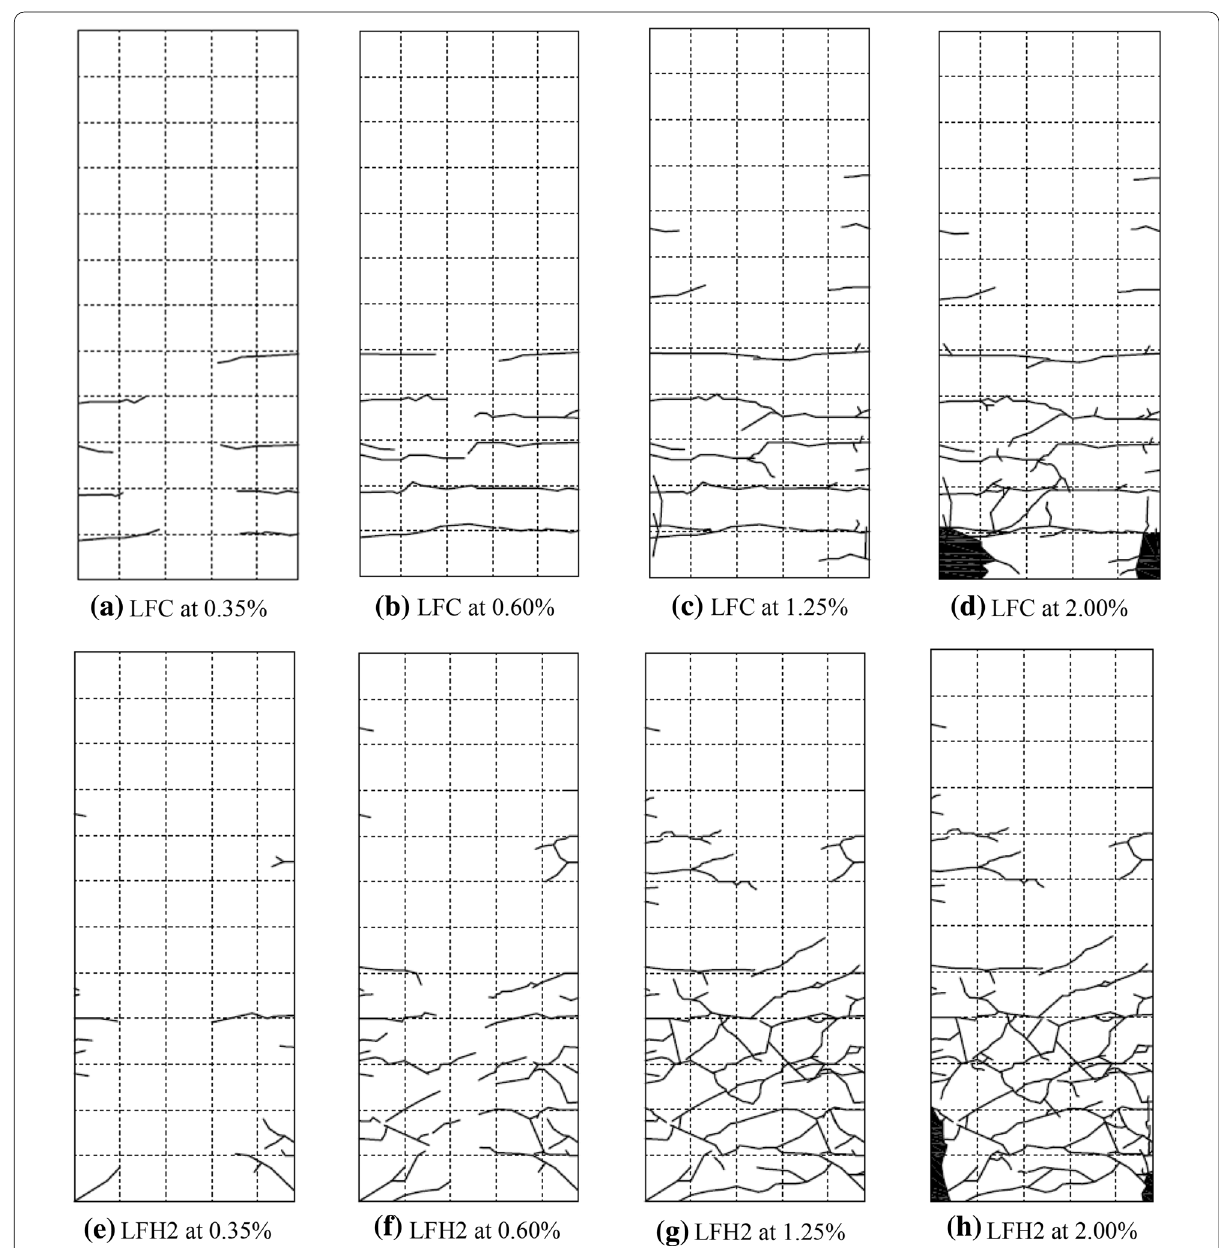
Fig. 9 Damaged modes of specimens LFC and LFH2 at 0.35%, 0.60%, 1.25% and 2.00% drift